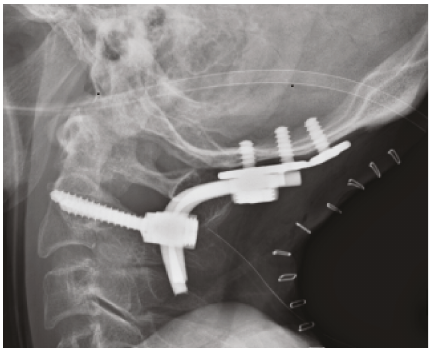
Figure 3: Postoperative radiograph shows occipitocervical fusion achieved by an occipital plate and bilateral C2 pedicle screws.